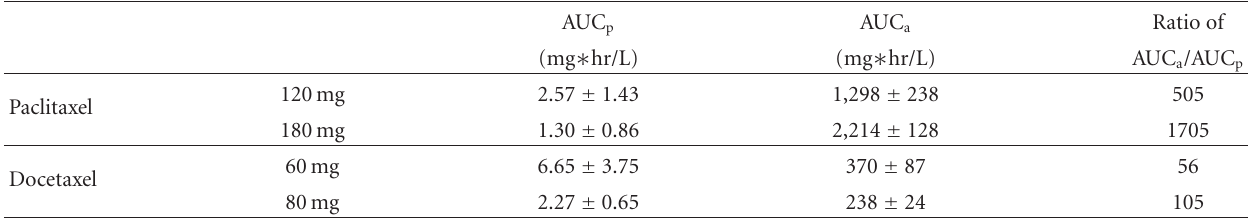
Table 1: The values of AUC of paclitaxel and docetaxel in plasma and ascitic fluid after an i.p. infusion of Taxol and Taxotere in patients with peritoneal tumor [7]. AUC p AUC a Ratio of (mg ∗ hr/L) (mg ∗